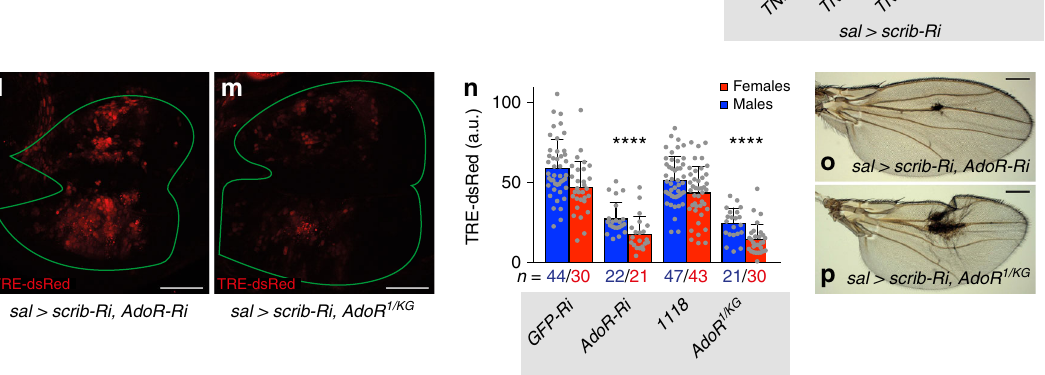
Fig. 1 AdoR signalling enhances JNK pathway activity during chronic polarity stress. a – g Silencing scrib ( sal > scrib-Ri ) activates the JNK sensor TRE-dsRed in the wing disc and causes severe damage in the adult wing. These effects are suppressed by expression of JNK bskDN or the inhibitor of JNK, puc . h – k Expression of TRE-dsRed is also suppressed by knockdown of TNFR grnd or in a TNF egr mutant. It is partially suppressed by TNF egr knockdown. l – p Similarly, TRE-dsRed is suppressed and wing damage is rescued following AdoR knockdown or in an AdoR mutant. Scale bars, 50 μ m ( a – c , h – j , l , m ) and 0.5 mm ( e – g , o , p ). In graphs, means are shown, and error bars represent ± SD; **** P < 0.0001, unpaired two-tailed Student ’ s t -test (males and females pooled together). As in all subsequent fi gures, confocal images are maximal intensity projections of z -stacks, male third instar wing imaginal discs are shown with posterior to the right and dorsal up and a green line marks the domain of sal -Gal4 expression, as determined by the activation of a UAS-cd8GFP transgene (see detailed genotypes in Methods). e – g , o , p are representative images of male adult